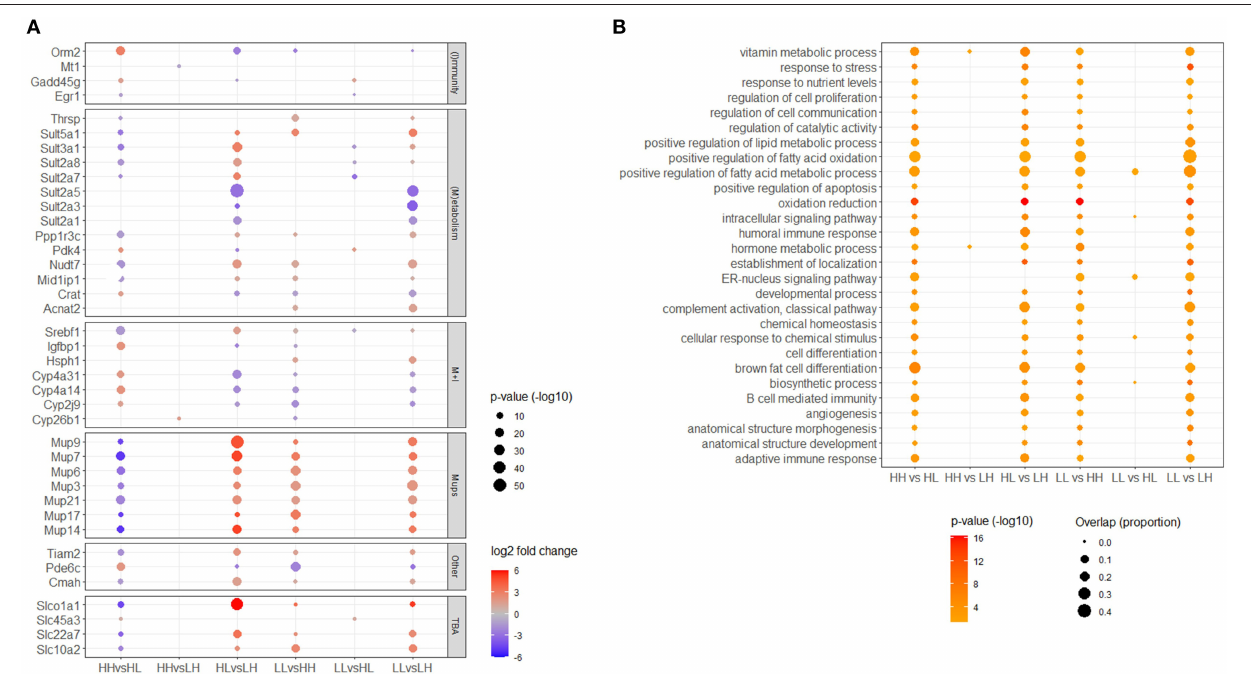
FIGURE 4 | (A) Top genes. Selection was based on the gene being differentially expressed within the top 20 most significant hits in more than one comparison, and belonging to a recognizable cluster of functional categories. TBA: transport of bile acids. (B) Representative top shared Gene Ontology biological processes (GO_BPs). Selected terms are representative of all different GO_BP terms enriched in at least four of the comparisons. Only significant (adjusted p < 0.05) genes and functional terms are